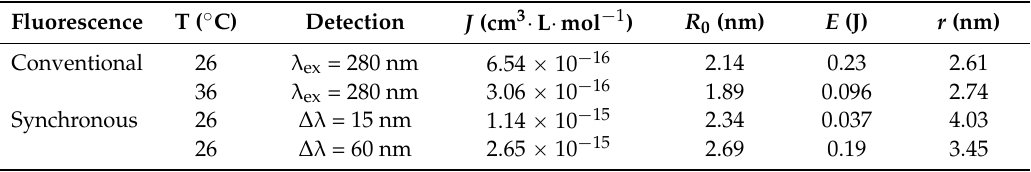
Table 5. Energy transfer parameters between SSC and